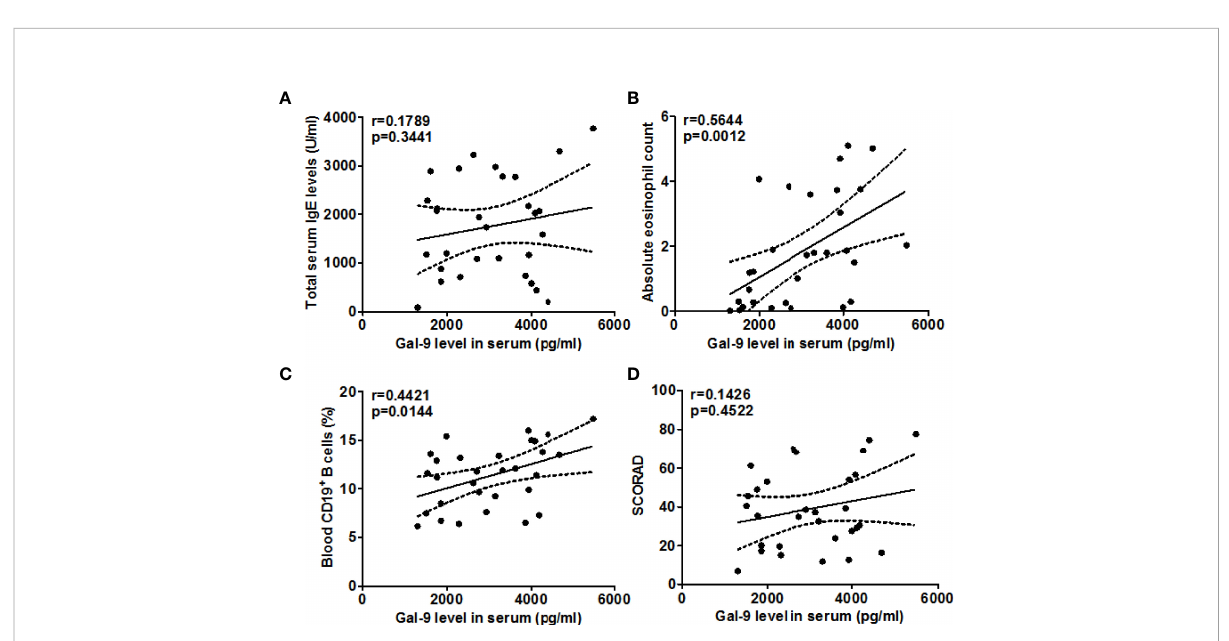
FIGURE 4 Association between the serum Gal-9 levels and total IgE (A) , eosinophils (B) , CD19 + B cells (C) , and SCORAD (D) in patients with